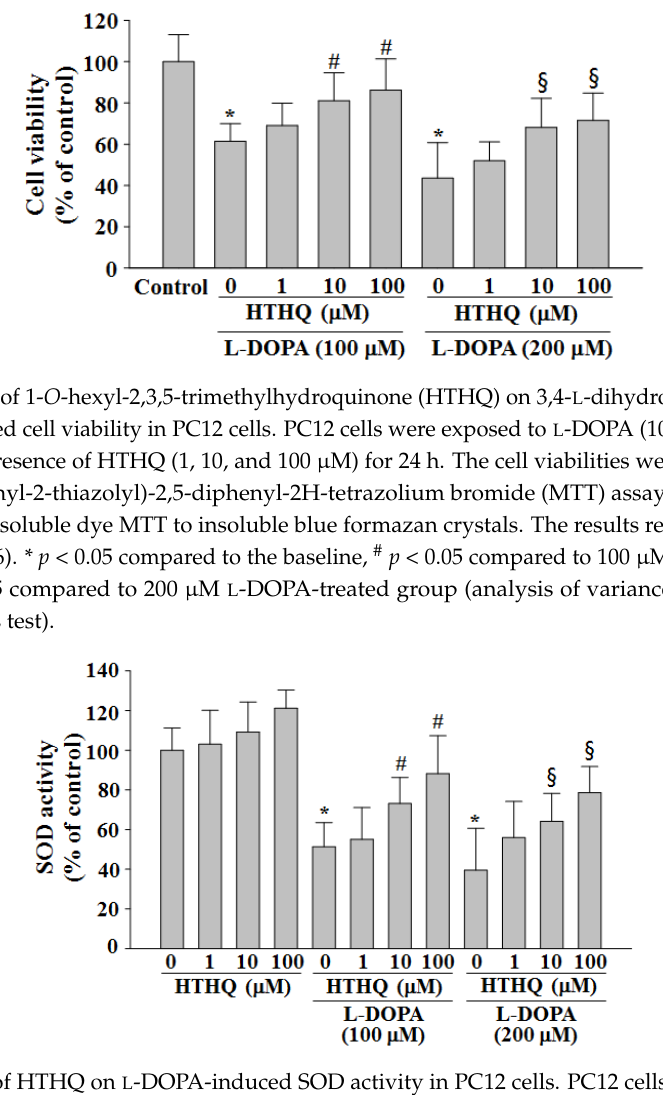
Figure 2. Effect of HTHQ on L -DOPA-induced SOD activity in PC12 cells. PC12 cells were exposed to